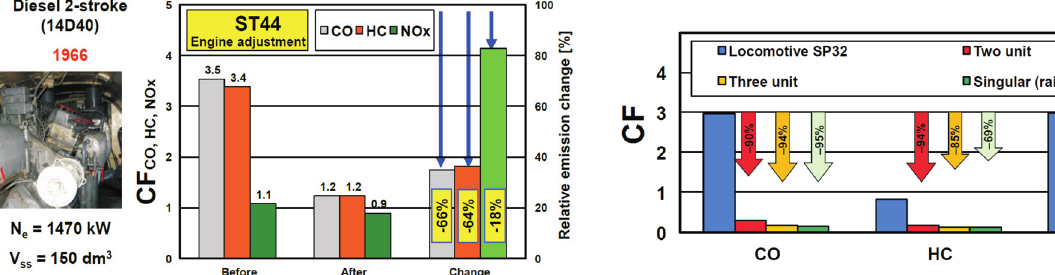
Fig. 17. The proposal of changes of the rolling